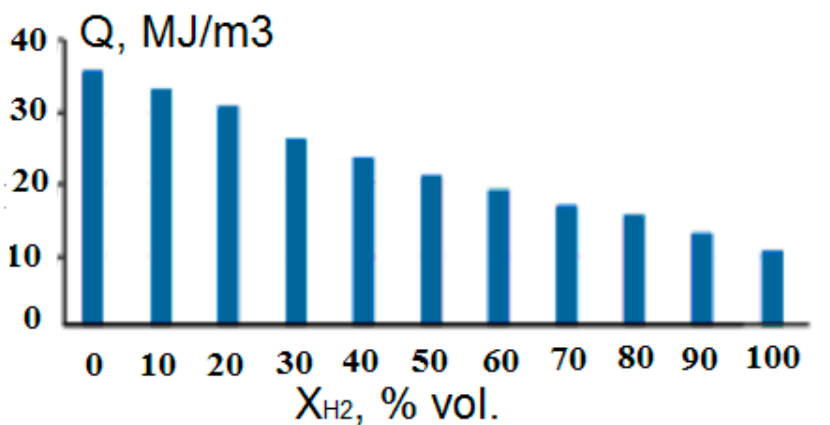
Figure 15. Dependence of energy costs for compressing a methane–hydrogen mixture with a pressure of 1 MPa on the concentration of hydrogen in it (Adapted from ref. [82]).